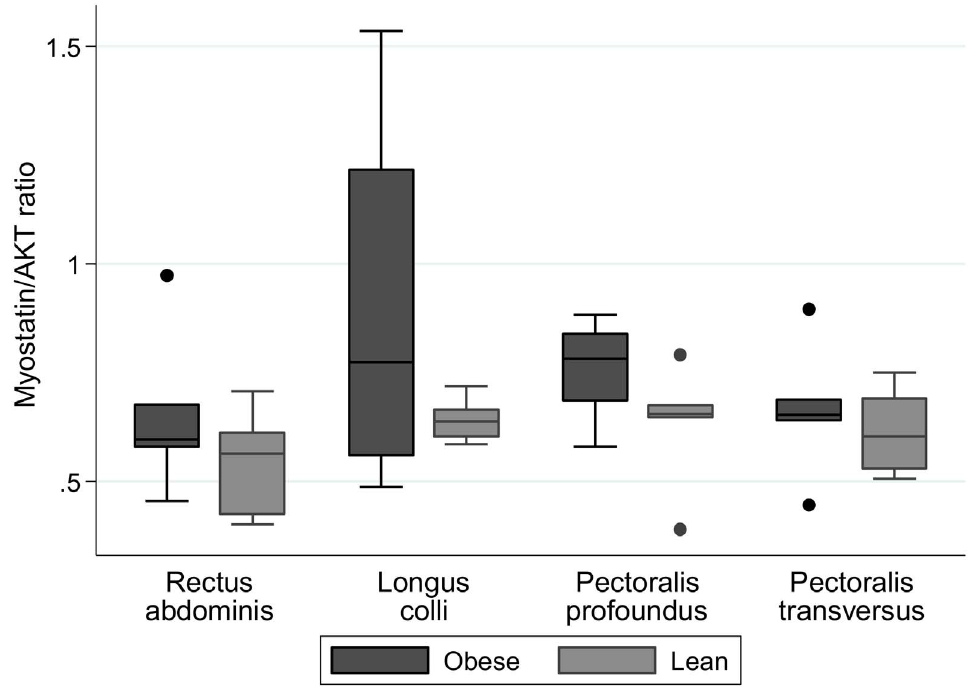
Figure 3. Protein expression of Myostatin precursor protein in skeletal muscles of lean and obese horses and ponies. Protein expression of myostatin precursor protein ( , 45 kDa) was assessed by Western blot with total AKT used as a loading control. Mean densitometric signals were calculated from three independently repeated Western blots. n=6/group.